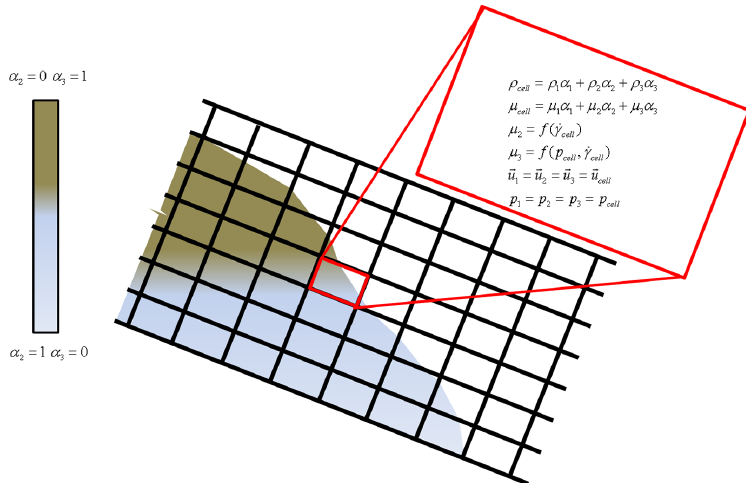
Figure 2. Longitudinal section through a debris-flow front discretized with finite-volume cells, showing the constitutive equations for one cell with density ρ and viscosity µ , given the densities ρ 1 ... 3 , viscosities µ 1 ... 3 , and proportions α 1 ... 3 of phases present. The numbers 1, 2, and 3 denote the air (white colored cell content), mud, and gravel phases,